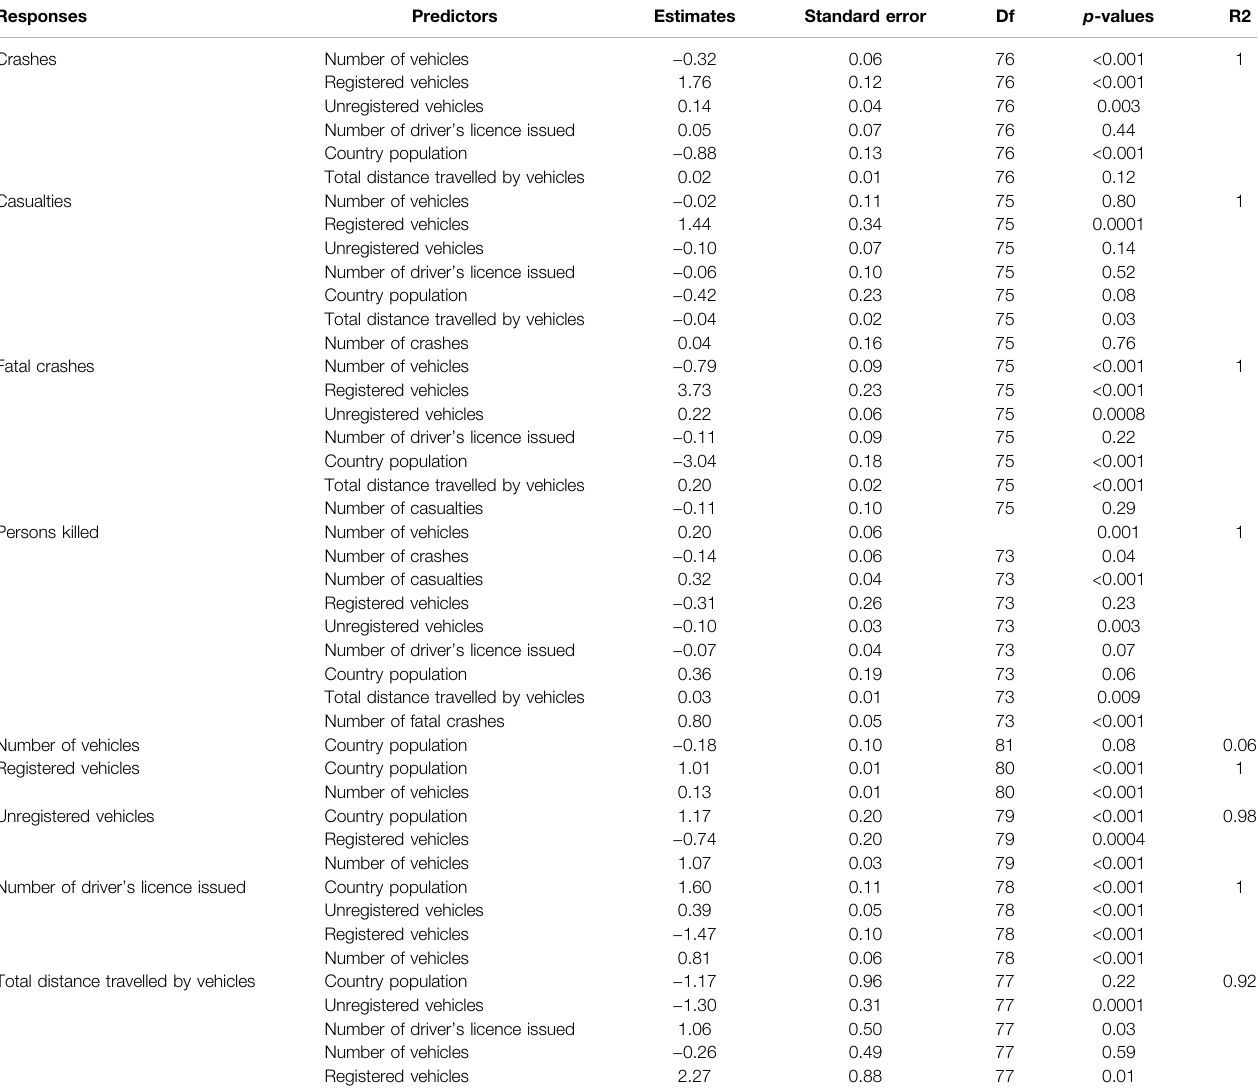
TABLE 1 | Coef fi cients of the structural equation model fi t to the dataset analysed in the present study.